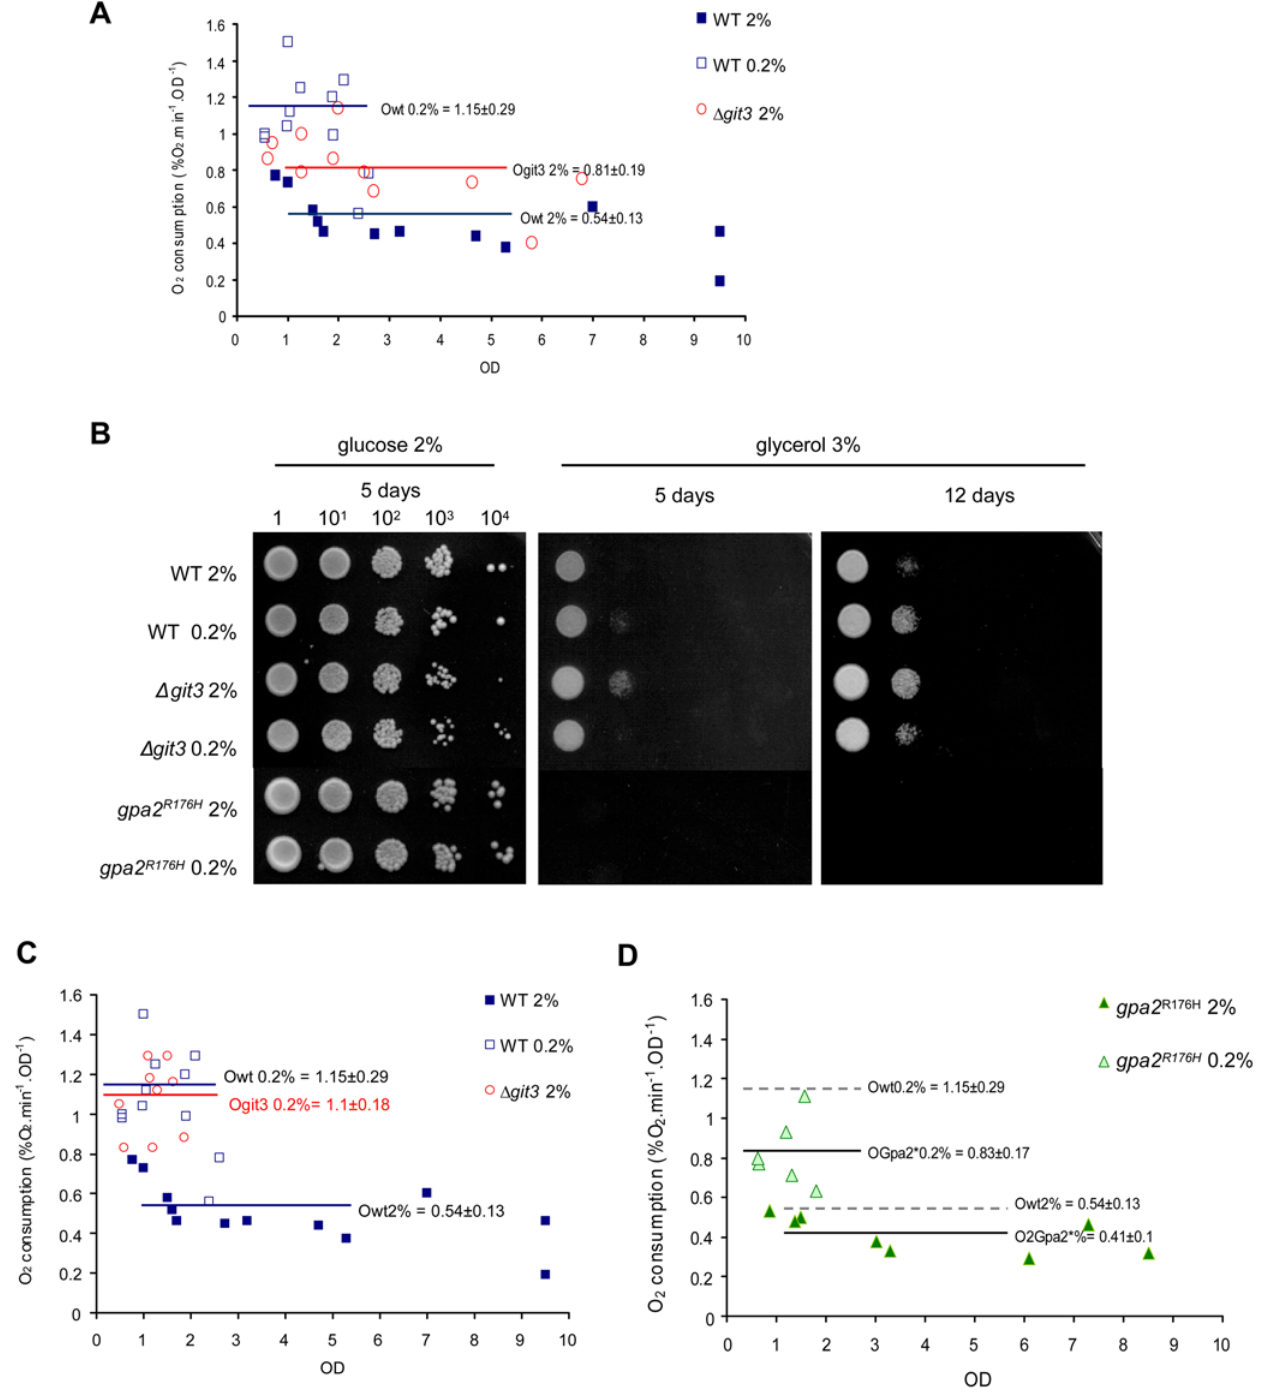
Figure 3. Respiration rate is increased in both CR and in strains with defects in glucose signaling. (A) Oxygen consumption measured using a Clark electrode for WT in low and high glucose, and for glucose receptor deleted strain D git3 . Owt, Ogit3 represents the average of the oxygen consumption in exponential phase (calculated with OD 595 , 7 at 2% glucose and OD 595 , 2.1 at 0.2% glucose). (B) Growth of WT, D git3 and gpa2 R176H switched from fermentative glucose medium to respiratory glycerol medium. (C) Oxygen consumption of D git3 at 0.2% glucose as compared to wild type. (D) Oxygen consumption for constitutively active G a subunit ( gpa2 R176H ) in low and high glucose as compared to WT. Ow t , OGpa2* represents the average of the oxygen consumption in exponential phase (calculated with OD 595 , 7 at 2% glucose and OD 595 , 2.1 at 0.2% glucose).